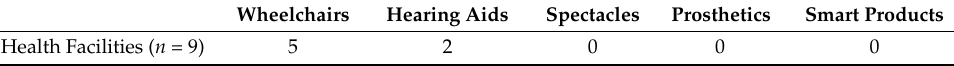
Figure 3. Number of health facilities with availability of mobility ‐ related assistive devices.